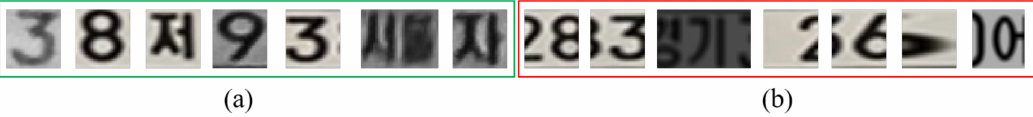
Figure 8. The results of character segmentation, including some successful cases ( a ) and some failure cases ( b ).